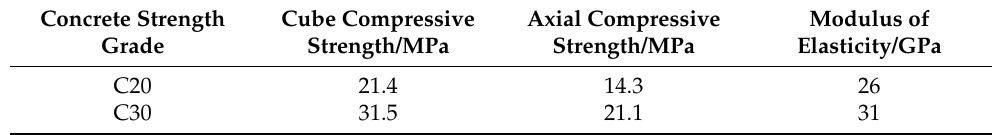
Table 2. Mechanical properties of concrete indices of concrete.